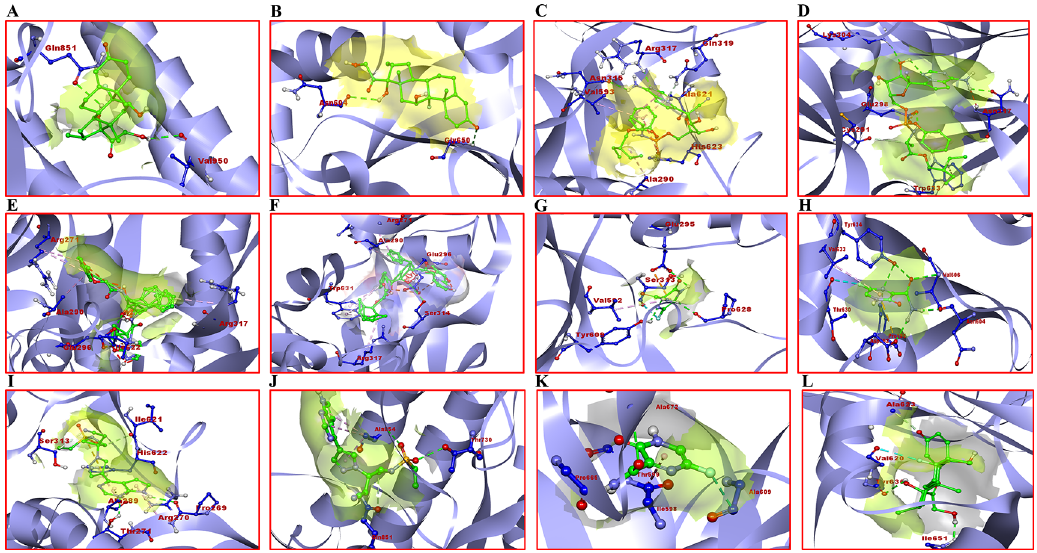
Figure1.BindinginteractionsofSARS-CoV-2surfaceglycoproteinwithselecteddrugsofhighandlowbinding energiesfordifferentvariantsofconcern(VOCs). A)B.1.617.2withdexamethasone;B)AY.1withdexamethasone; C) B.1.351 with remdesivir; D) P.1 with remdesivir; E) B.1.351 with lopinavir; F) AY.1 with lopinavir; G) B.1.1.7 with favipiravir; H) AY.1 favipiravir; I) B.1.351 with baricitinib; J) B.1.617.2 with baricitinib; K) wild type; (WT) with favipiravir; L) WT with